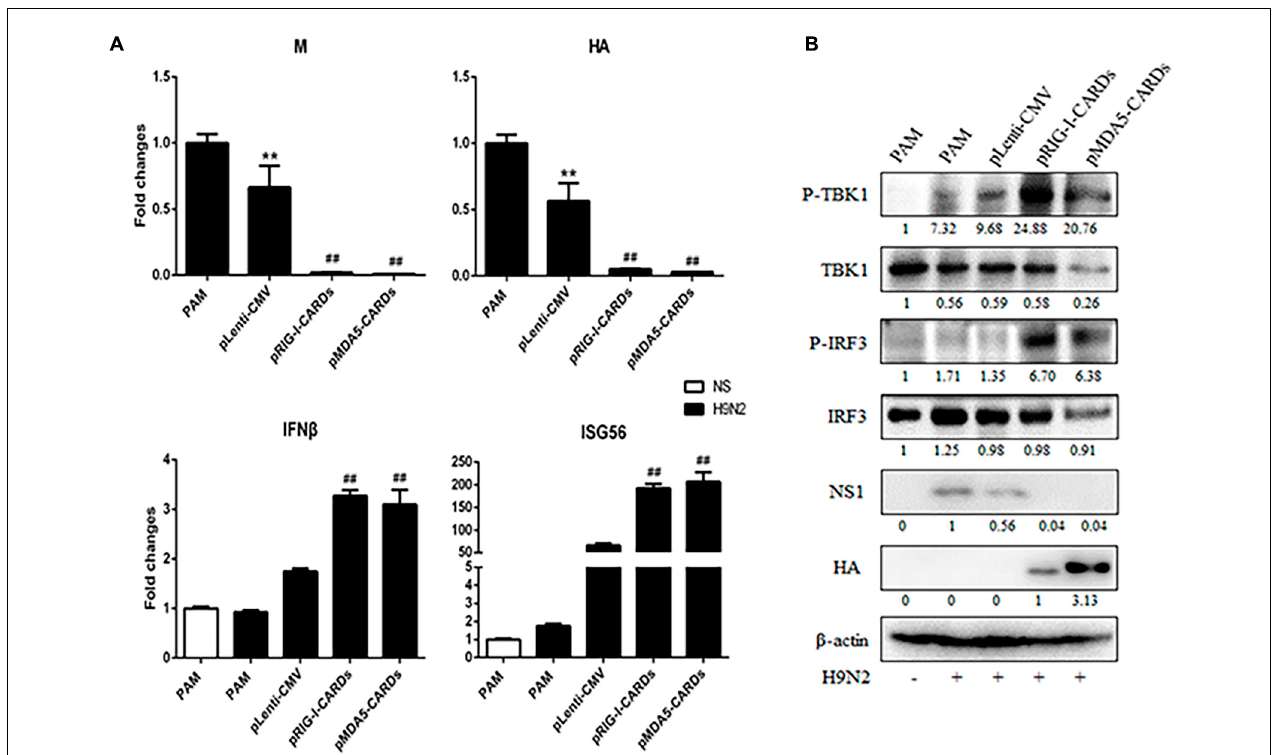
FIGURE 5 | The anti-influenza virus H9N2 activity of porcine RIG-I and MDA5 CARDs. PAMs grown on 24-well plates (3 × 10 5 cells/well) were transfected with CARDs expression plasmids and pLenti-CMV vector (0.5 µ g each) using TransIT-LT1 Transfection Reagent for 24 h. Then the cells were infected with H9N2 virus at MOI of 0.01 for 12 h. The cells samples were analyzed by RT-qPCR for virus replication and downstream gene expressions as indicated (A) or detected by Western-blotting using the indicated antibodies (B) . The densitometry values after actin normalization were shown below the blots. ** p < 0.01 vs. blank controls; ## p < 0.01 vs. vector